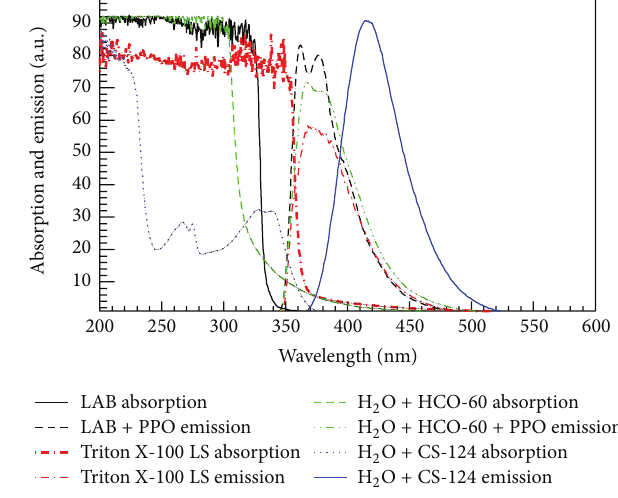
Figure 7: The absorption and the emission spectra of S1 (Triton X-100), S2 (CS-124), and S3 (HCO-60) samples, respectively. The overlap of absorption and emission spectra in each sample group can be